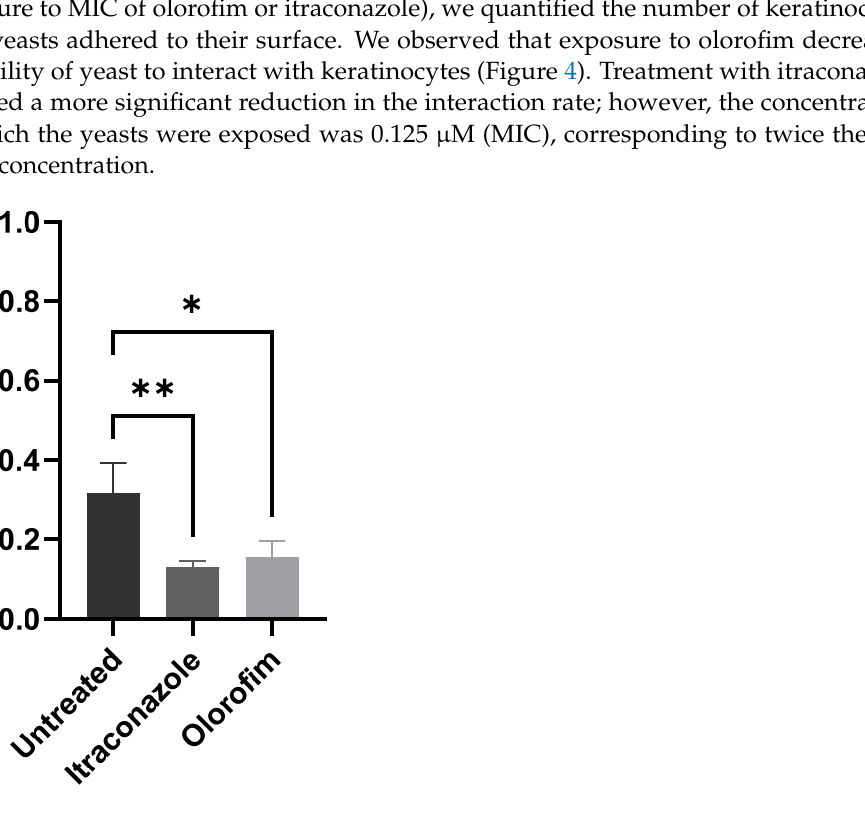
Figure 4. Interaction between keratinocytes and S. brasiliensis yeasts. Yeasts treated with MIC of compounds (0.06 µM olorofim or 0.125 µM itraconazole) displayed decreased ability to adhere to the surface of keratinocytes. * p < 0.05 and ** p < 0.01 by one-way ANOVA.